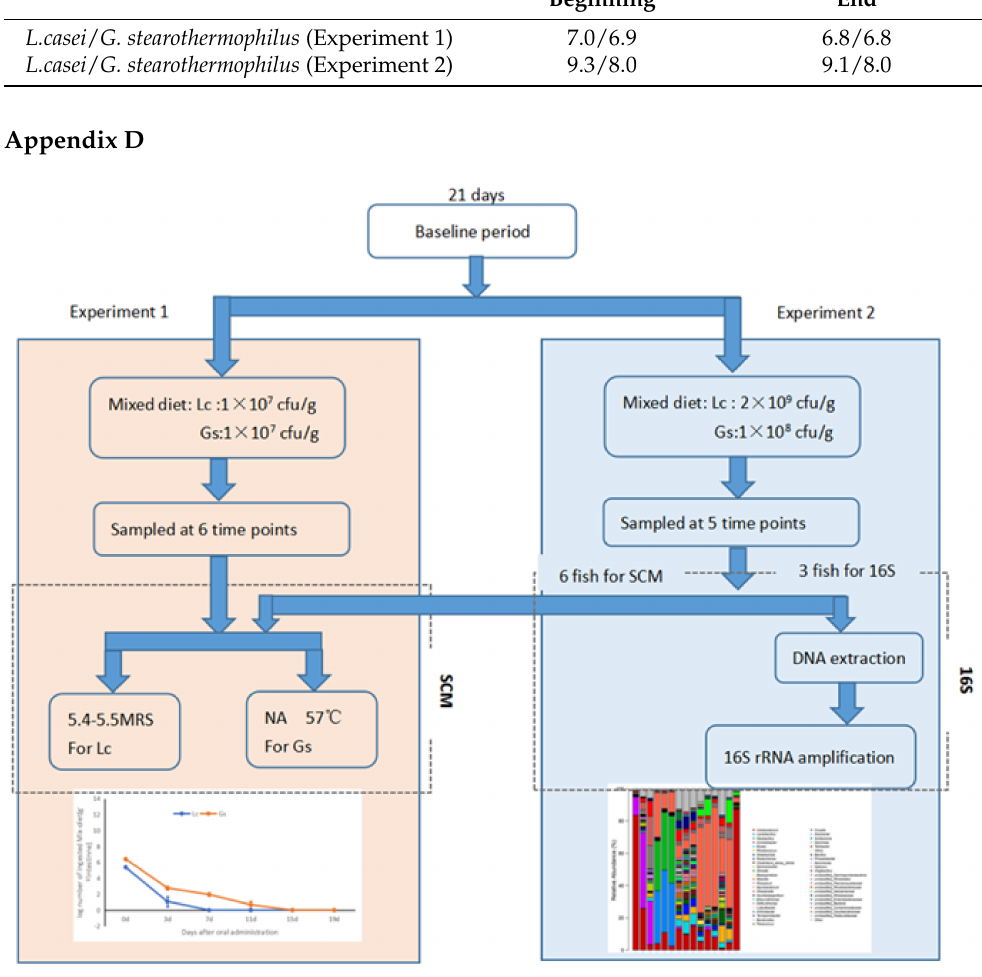
Figure A1. The flow chart of design of